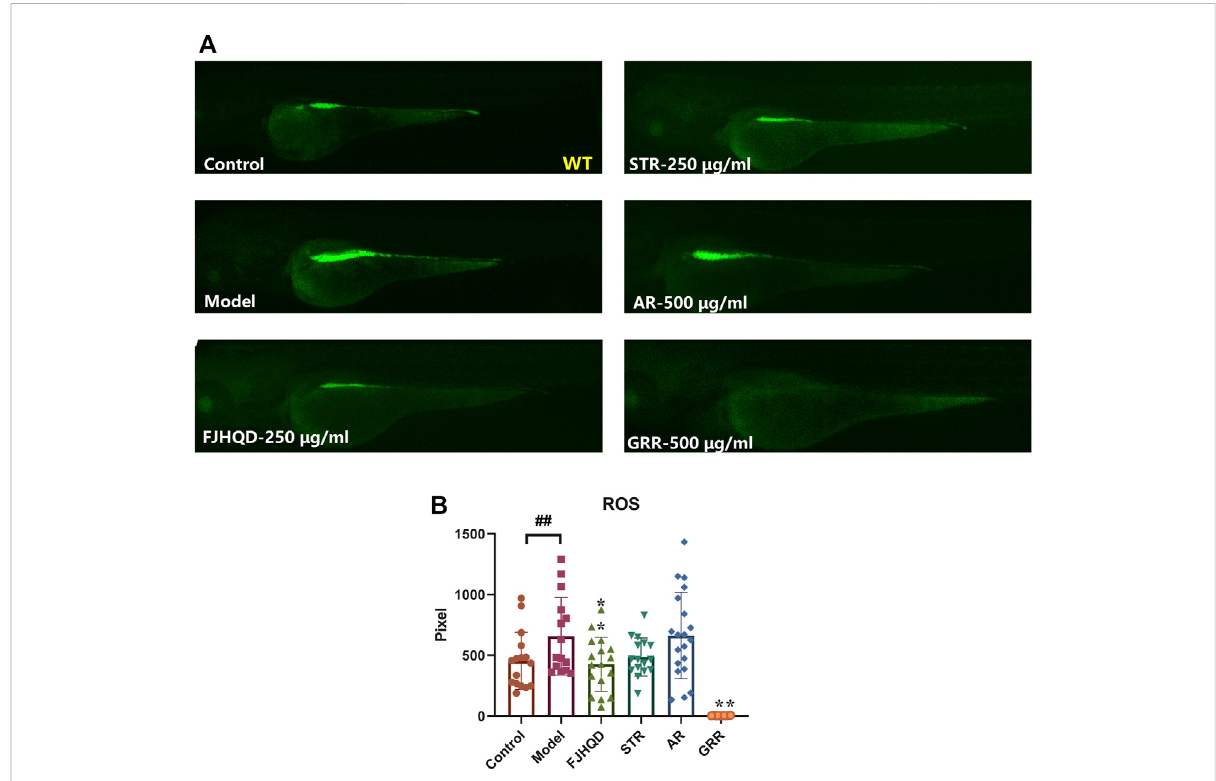
FIGURE 4 FJHQD,STRandGRRinhibitoxidativedamagesinverapamil-inducedheartfailurezebra fi sh.Representativeimages (A) andquanti fi cation (B) of the fl uorescence signals of DCFH-DA probe in control or verapamil treated larvae with or without botanical drugs extracts. N ≥ 11. # p < 0.05 vs . Control, ## p < 0.01 vs . Control, * p < 0.05 vs . Model, ** p < 0.01 vs .